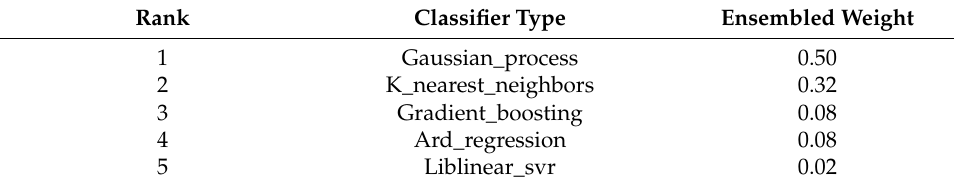
Table 2. The classifiers type and ensembled weight in the AutoML model.